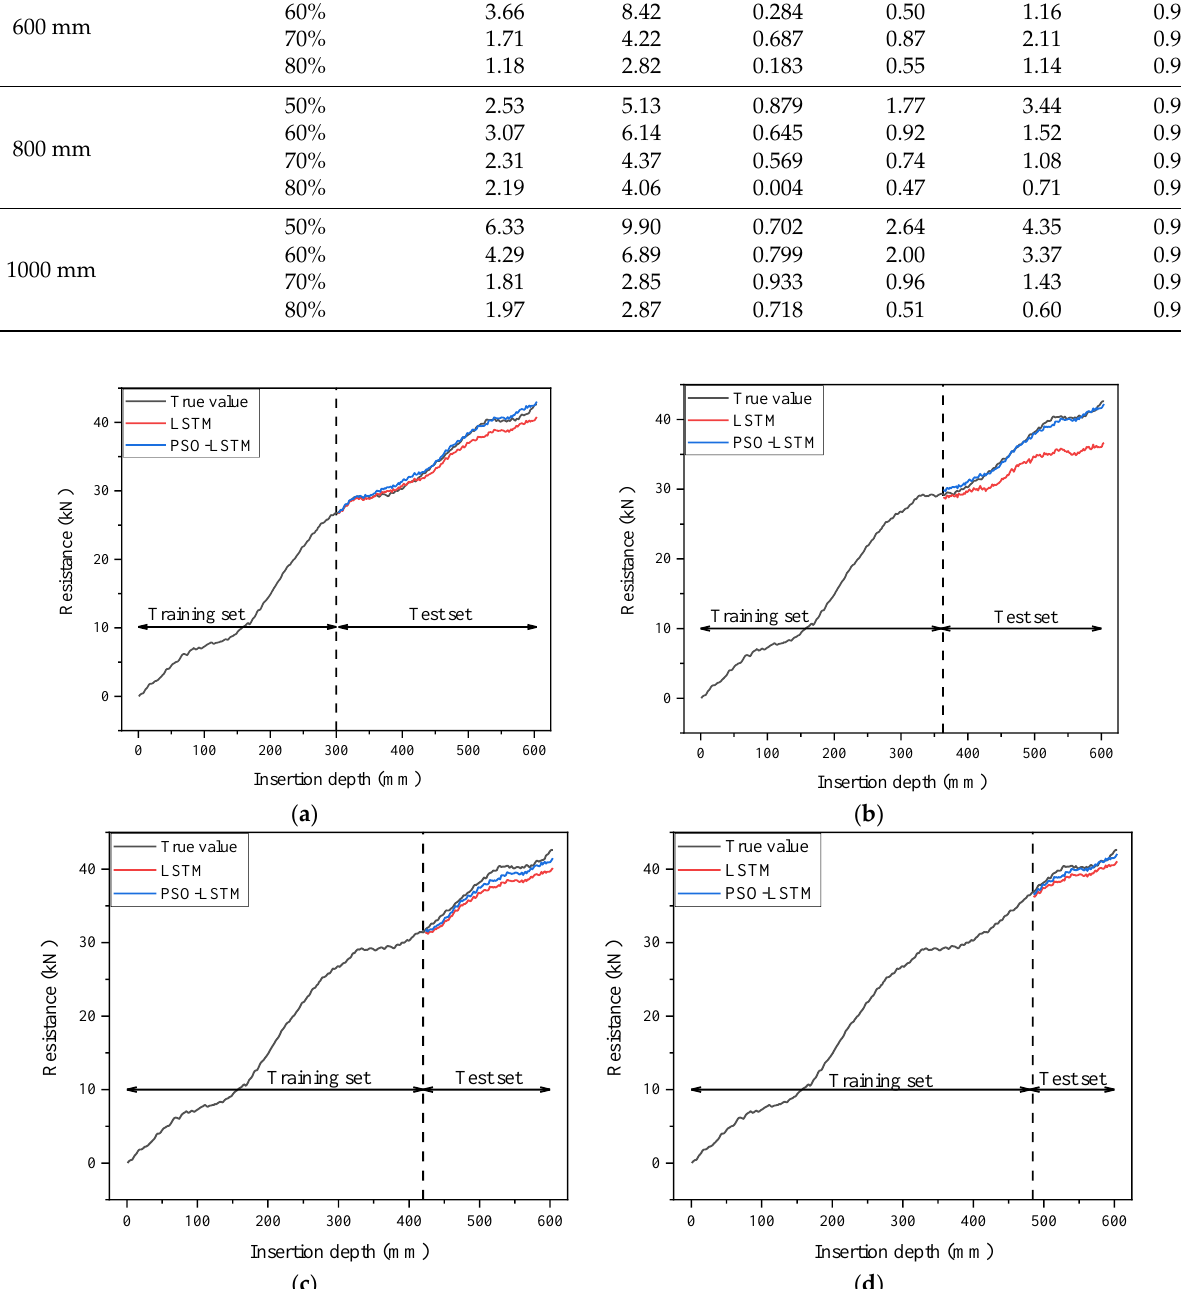
Figure 20. Sand samples with an insertion depth of 600 mm. ( a ) The training set proportion of 50%; ( b ) The training set proportion of 60%; ( c ) The training set proportion of 70%; ( d ) The training set proportion of 80%.